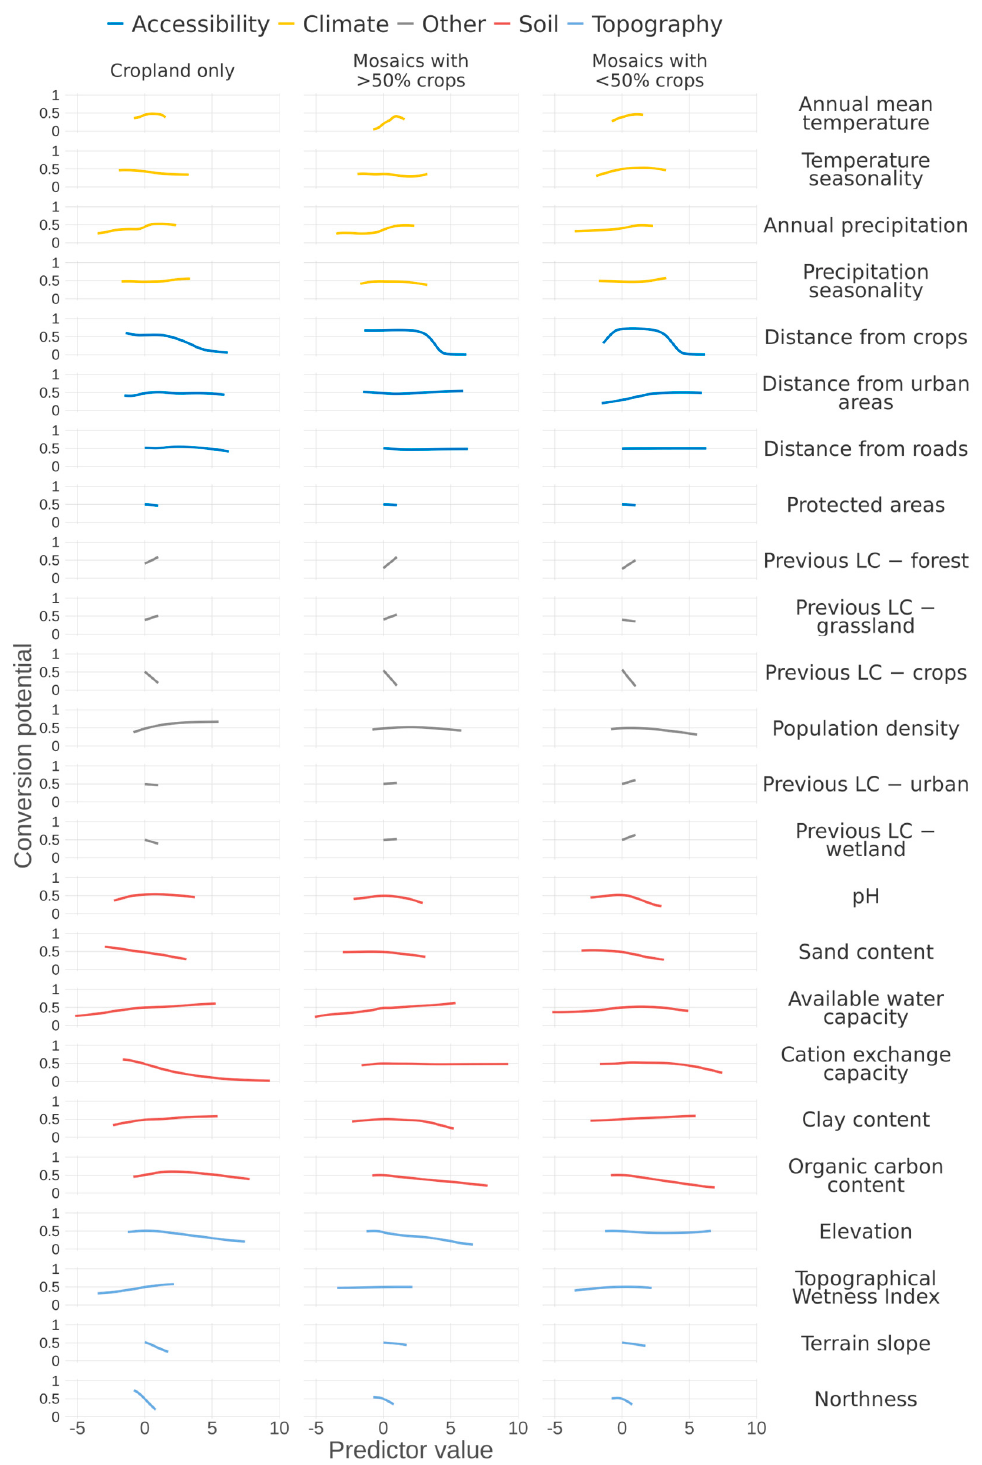
Figure 4. Partial dependence plots showing the change in conversion potential in relation to each of the predictors (standardized values) for cropland only ( left ), mosaics with >50% crops ( centre ), and mosaics with <50% crops ( right ).